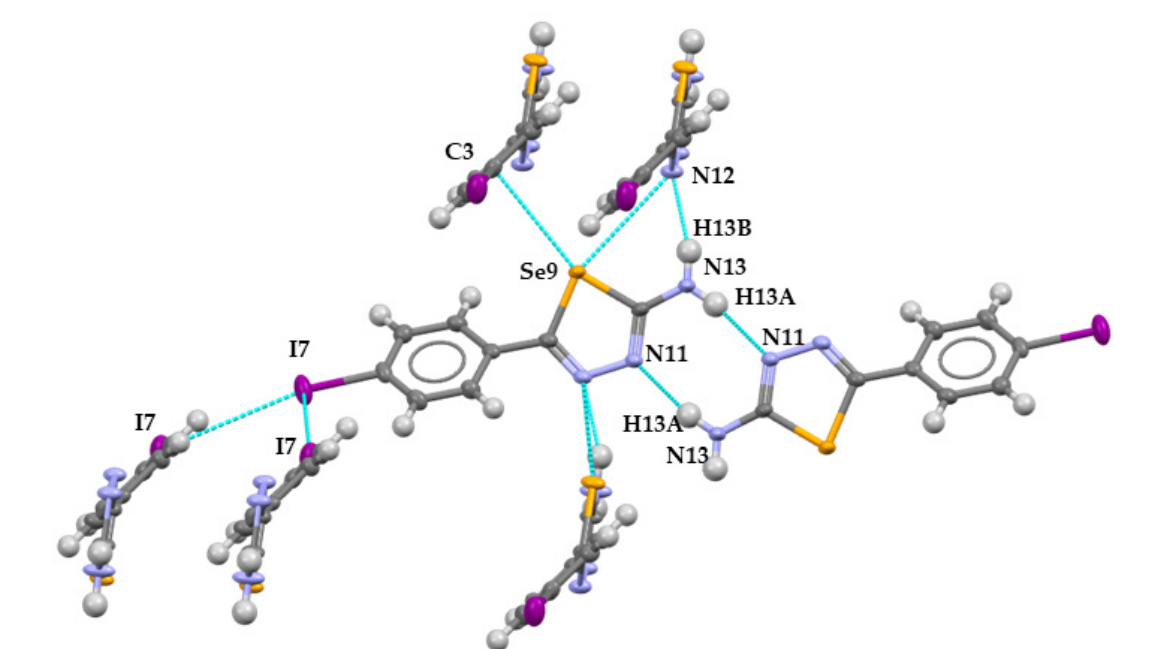
Figure 8. Structure directing interactions in the crystal structure of T1-Se-I. All relevant hydrogen, halogen and chalcogen bond geometries of T1-S-Br, T1-Se-Br, T1-S-I and T1-Se-I are given in Table 2. Table 2. Hydrogen, halogen, and chalcogen bond parameters of the five crystal structures.